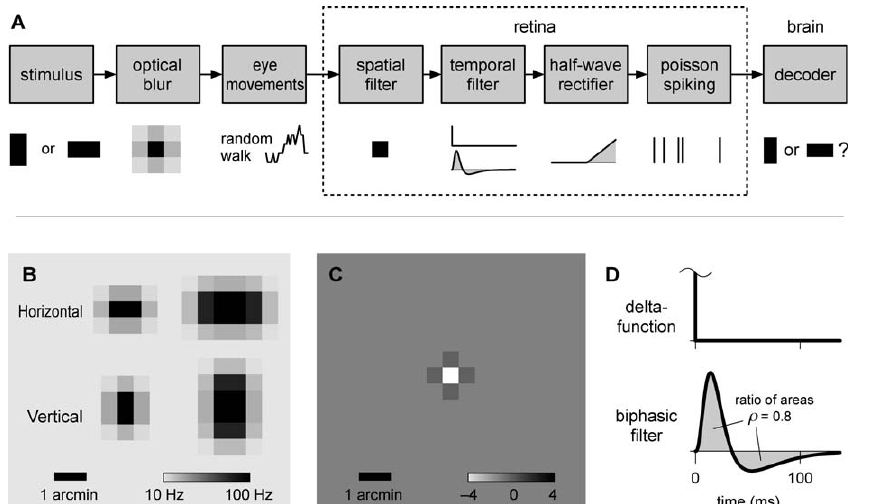
Figure 3. Models of Spike Generation and Decoding (A) A block diagram of the features in the model visual system; see text for details. (B) Firing-rate profiles r S ( y ) induced by horizontal and vertical stimuli on the model foveal lattice. Left: 0.5 3 1 arcmin 2 . Right: 1 3 2 arcmin 2 . (C) A graphical representation of the discrete second-derivative operator used to calculate diffusion rates. (D) The temporal filters that model retinal ganglion cells use to convert the time-varying light intensity into the instantaneous firing rate.